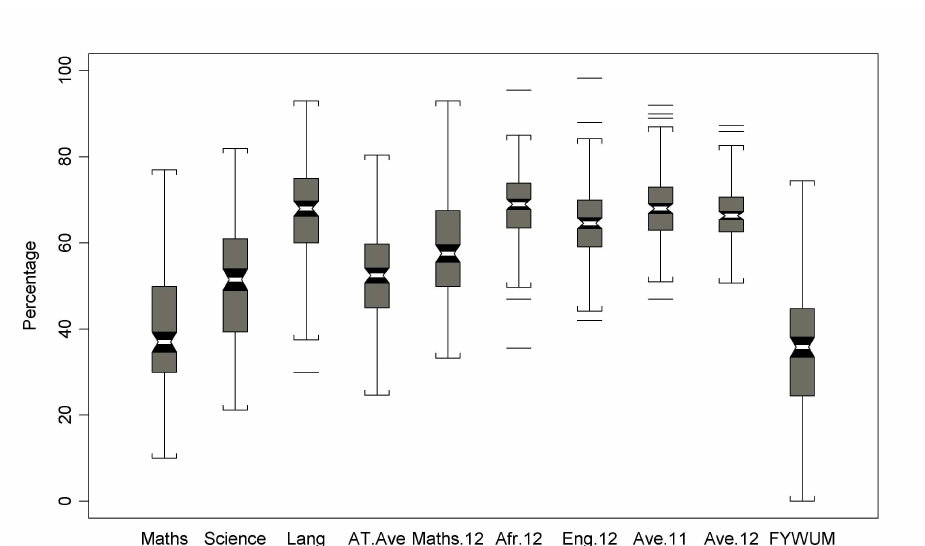
Figure 1: Notched boxplots of the variables of the Test Battery 1 data set for the 2000 intake